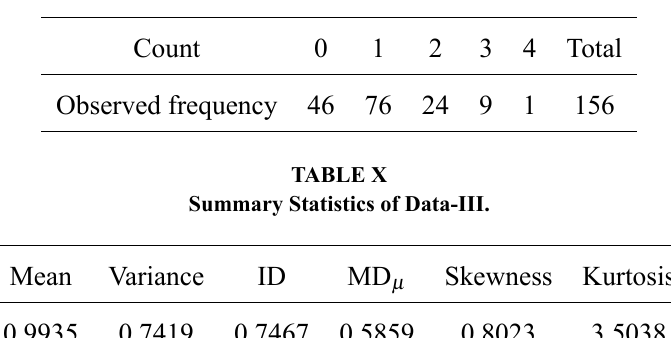
Number of outbreaks of strikes in UK coal mining industries.